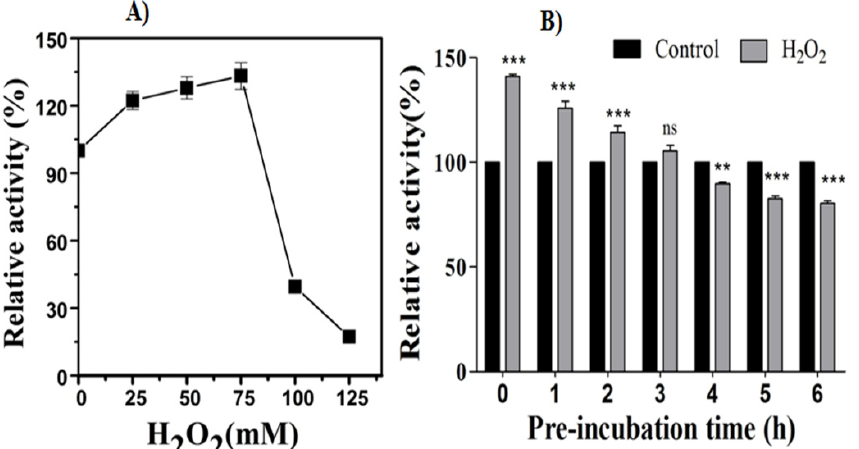
Figure 9. Effect of H 2 O 2 on β -Glucosidase activity. ( A ) Effect of different concentrations of H 2 O 2 (25, 50, 75, 100, 125 mM) on β -Glucosidase activity. The black boxes represent relative BGL activity with respect to no H 2 O 2 . The error bars indicate the means ± standard error mean (SEM) from three independent experiments, and ( B ) pre incubation has advantages in enhancing BGL activity in the presence of exogenous H 2 O 2 . H 2 O 2 tolerance of BGL activity was investigated by adding H 2 O 2 to bulk crude enzyme at different time points (0–6 h). The 0 mM H 2 O 2 pre incubation condition in this experiment was crude enzyme incubated in buffer without any H 2 O 2 . BGL activity without H 2 O 2 during 0–6 h pre incubation was defined as control (100%). The significant difference (**) was set at p < 0.01, and the highly significant difference (***) was set at p < 0.001 in Tukey’s t -test, compared to the 0% H 2 O 2 pre incubation control. Values are the mean ± SEM of results from three independent experiments.